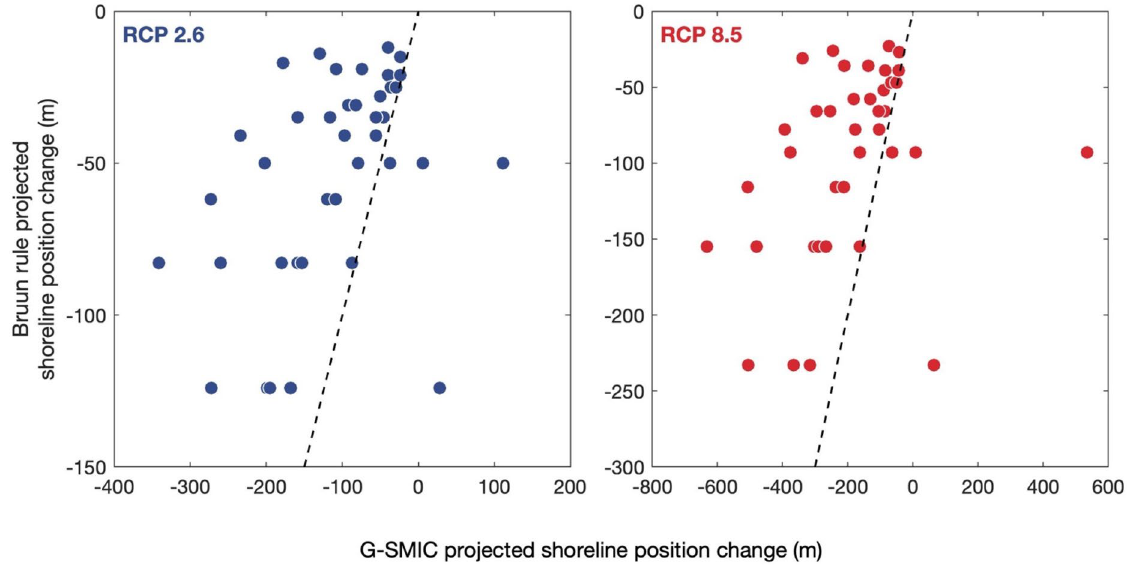
Figure 4. Comparison of projected median shoreline position change, derived through G-SMIC and the Bruun rule alone for 2091–2100. The diagonal dashed lines represent the perfect agreement between the two